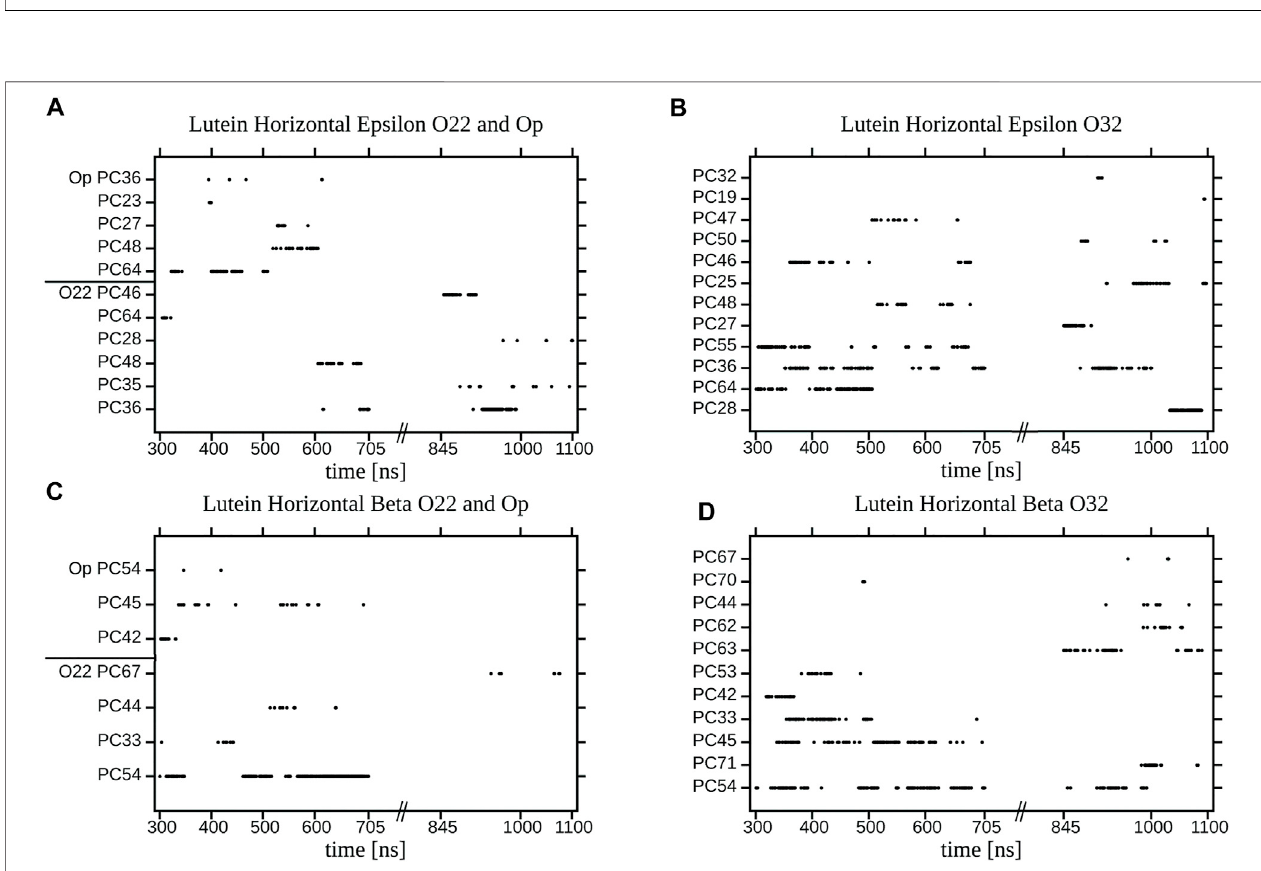
FIGURE12| DurationofanindividualH-bondingbetweentheOHgroupof (A,B) the ε -ring (C,D) the ß -ringofthehorizontalluteinand (A) O22andOp; (B) O32; (C) O22andOp; (D) O32,atomsofthespeci fi ed(numbered)POPCmoleculesinthePC-LUT_HbilayerfortwotimeperiodsofMDsimulation.Pointsrepresent fi rmbonding at a given time.